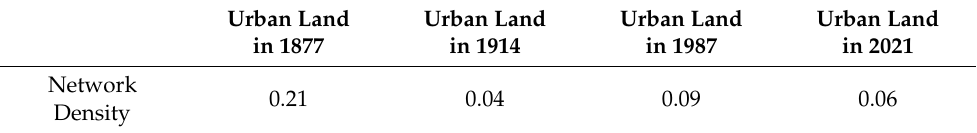
Table 3. Road Network Density in the Changsha Historic Urban Area in Various Periods.